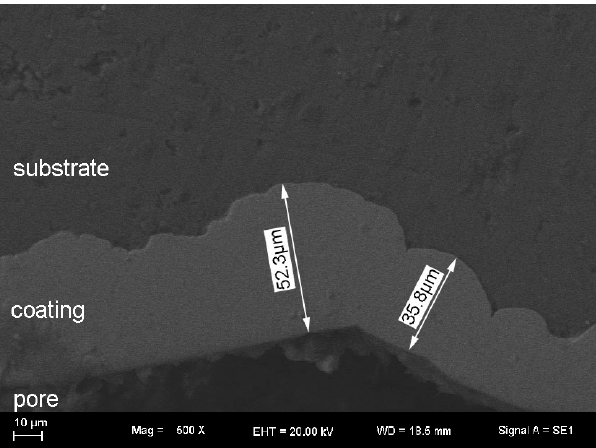
Figure 4. The cross section of electroless plating coating.